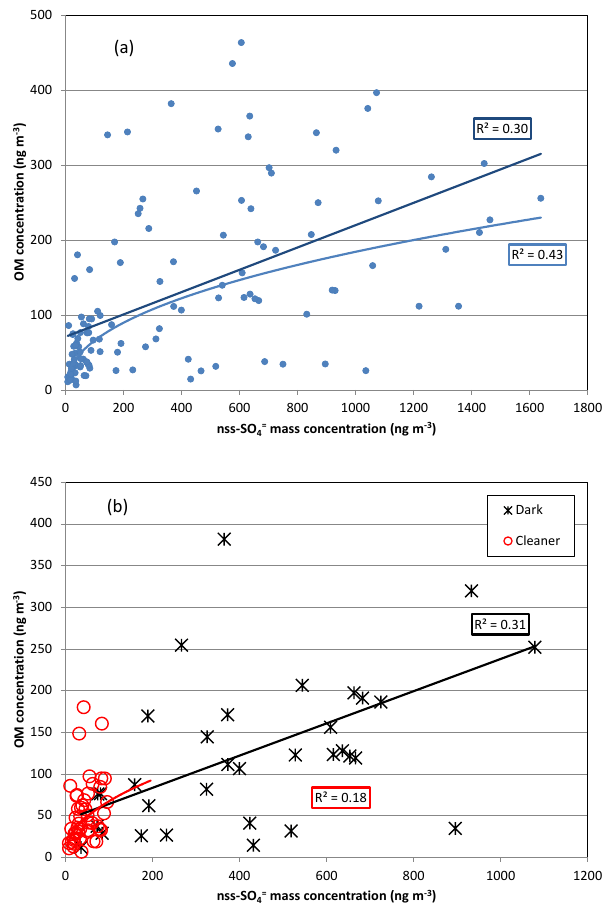
Figure 8. Regressions of OM versus nss-SO = and (b) dark weeks (during NDJF) and cleaner weeks (nss- SO = <100ngm − 3 ) . Coefficients of determination are indicated. 4 Linear and power-law regressions are shown for all points ( p <0.01), along with linear regressions for the dark period ( p <0.01) and the cleaner period ( p <0.03).